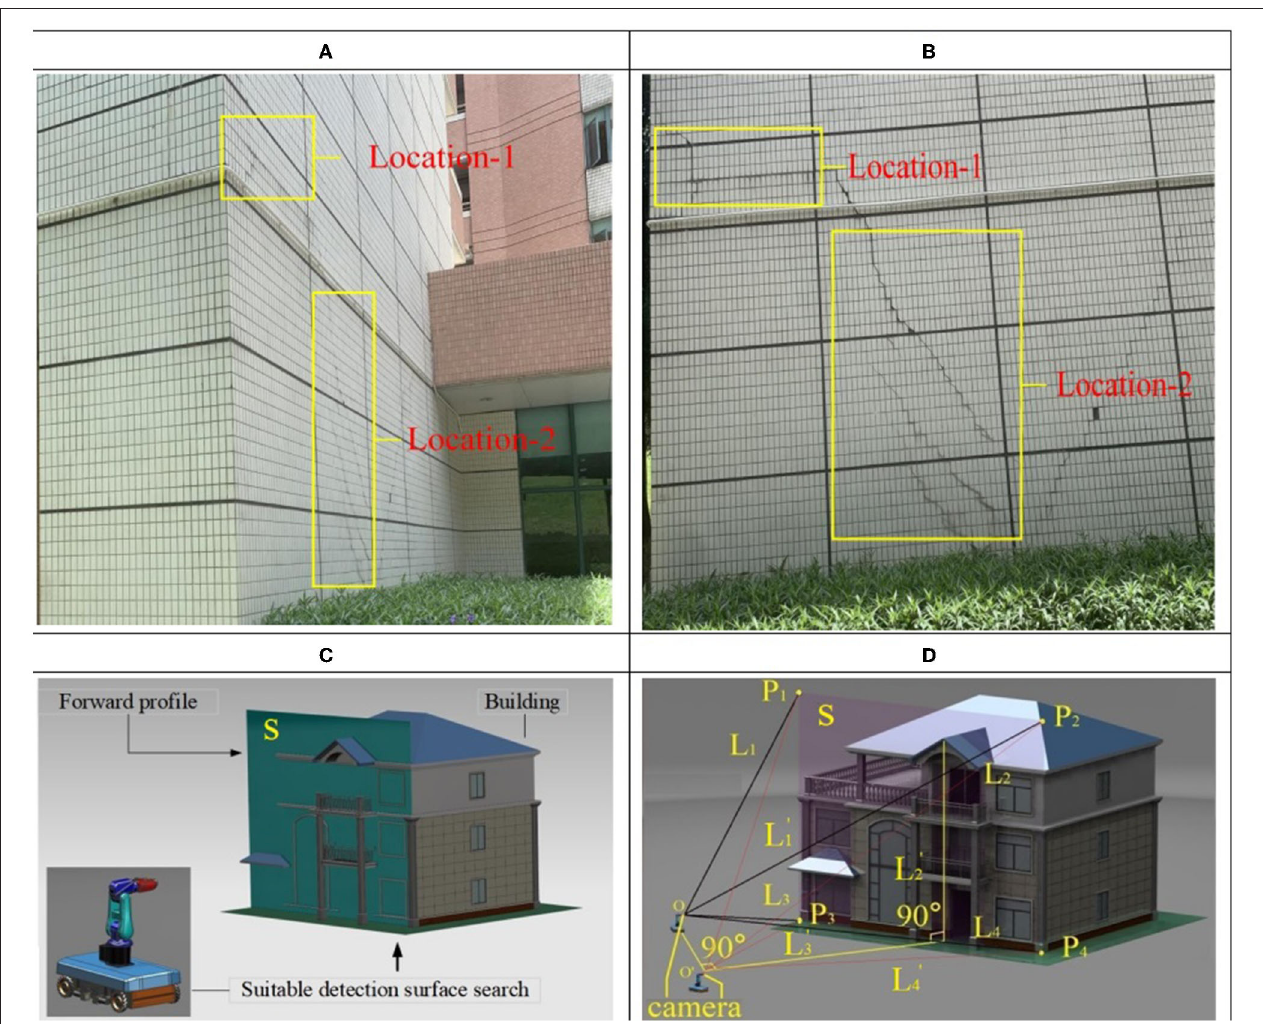
FIGURE 4 | Relationship between camera depth of field and shooting angle. (A) Take a photo from the front of the building. (B) Take a photo from the side face of the building. (C) Shooting angle planning. (D) Principle of shooting angle planning.